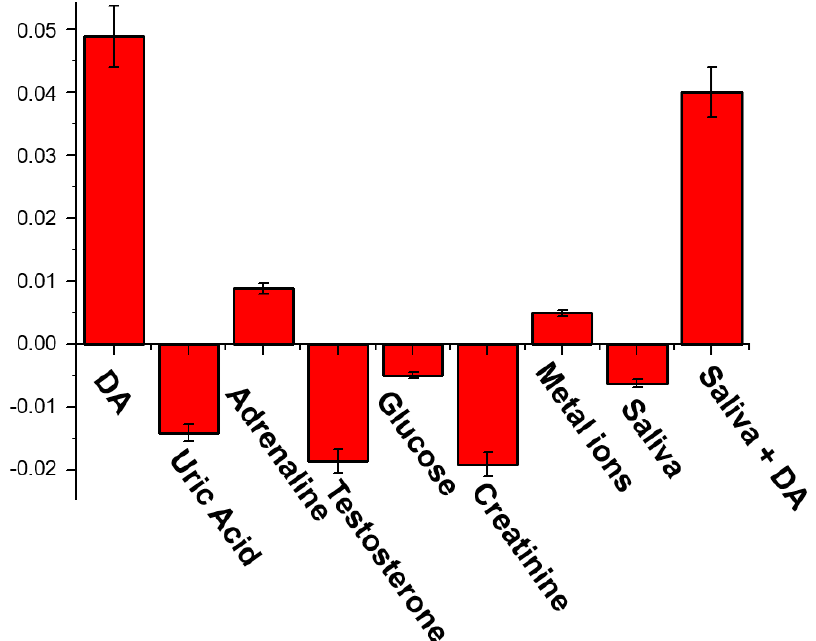
Figure 4. Selectivity tests: emission response (I-I 0 , where I and I 0 are the Gray channel emission values of each test image after and before the analyte exposition, respectively) of the solid sensor to different analytes dissolved in artificial saliva (composition: NaCl 2.9 mg/mL, KCl 6.35 mg/mL, Na 2 HPO 4 1.7 mg/mL, KH 2 PO 4 1.65 mg/mL, KSCN 0.8 mg/mL, CaCl 2 × 2H 2 O 0.85 mg/mL, Urea 1 mg/mL, NH 4 Cl 0.8 mg/mL, ascorbic acid 0.01 mg/mL), metal ions (MgCl 2 1 mg/mL, MnCl 2 1 mg/mL, FeCl 2 1 mg/mL, CuCl 2 1 mg/mL, ZnCl 2 1 mg/mL), real saliva and real saliva containing 0.1 nM of